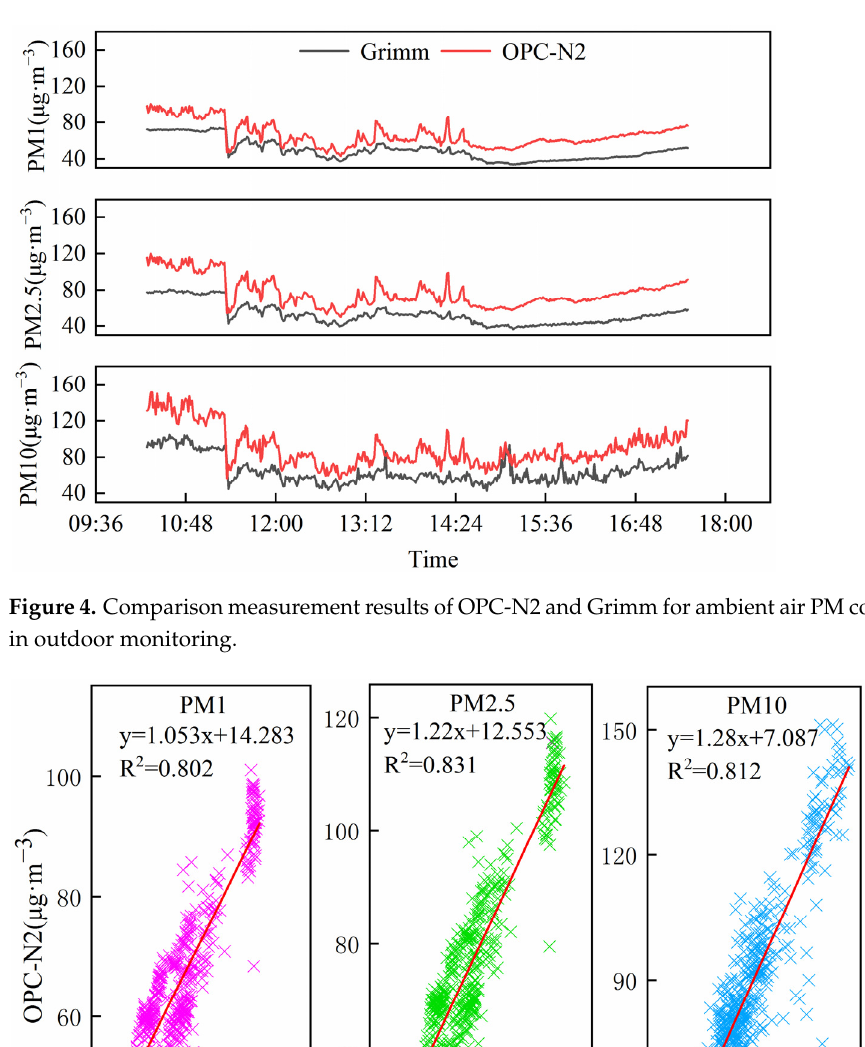
Figure 3. On ‐ situ photograph of PM measurement from the chimney by a self ‐ developed PM detec ‐ tor on an UAV.